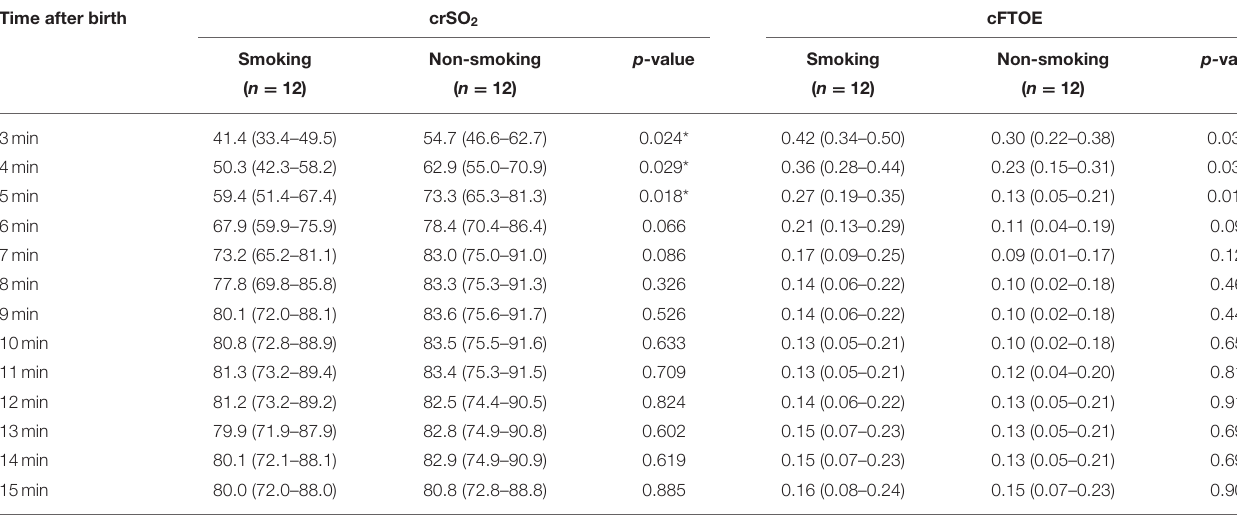
TABLE 2 | Cerebral regional oxygen saturation (%) and cerebral fractional tissue oxygen extraction in term neonates from mothers who had smoked during pregnancy compared to term neonates from mothers who had not smoked during pregnancy (smoking group and non-smoking group). Time after birth crSO